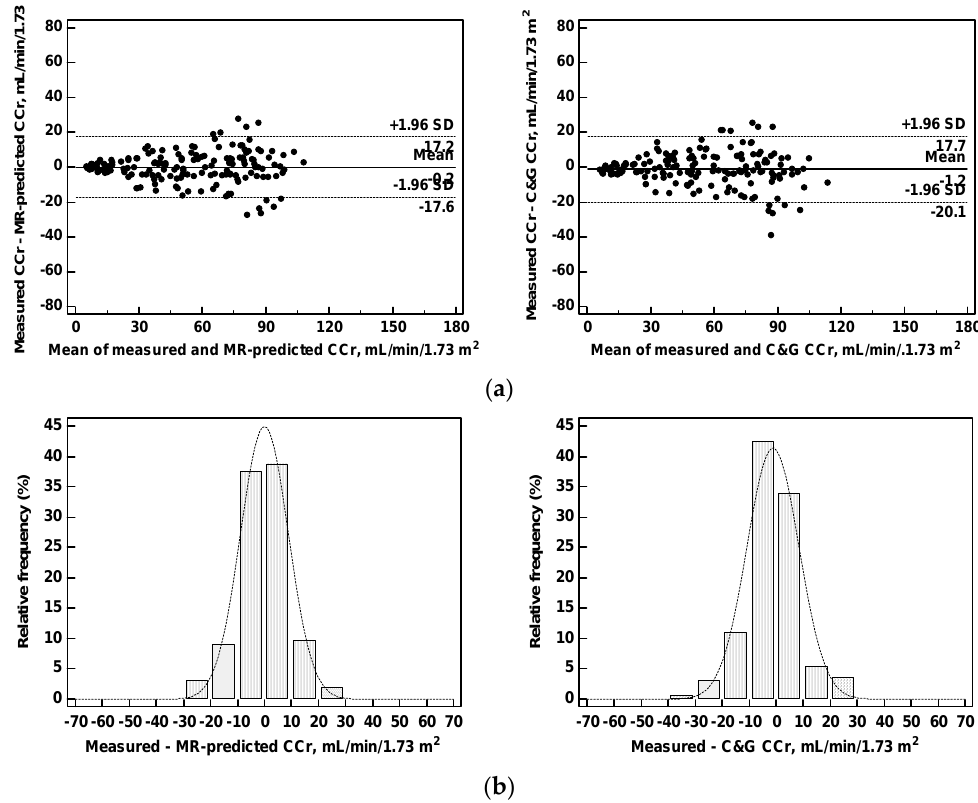
Figure 4. Measured versus predicted creatinine clearance: ( a ) Agreement plots between measured 24-h creatinine clearance (CCr) and creatinine clearance predicted from BCM and the multiple regression analysis equation (MR-predicted CCr). Creatinine clearance was predicted using the Cockcroft–Gault formula (C&G CCr); and ( b ) histograms of frequency distribution of the differences between measured and predicted clearances.